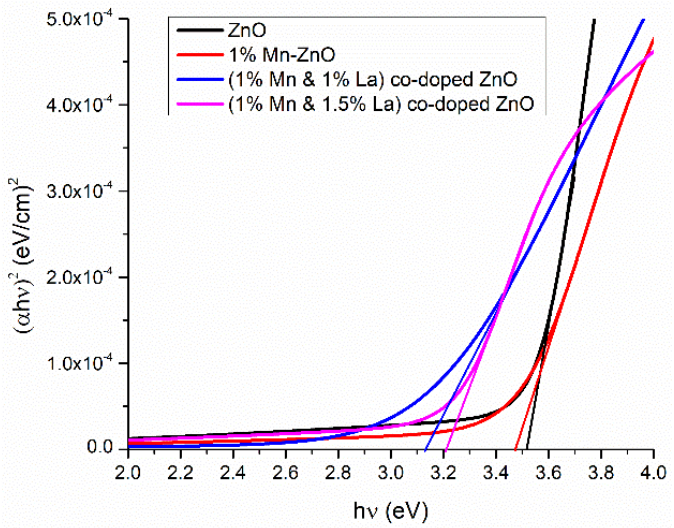
Figure 6. Band gap energy of pure and ZnO thin films co-doped with Mn and La.